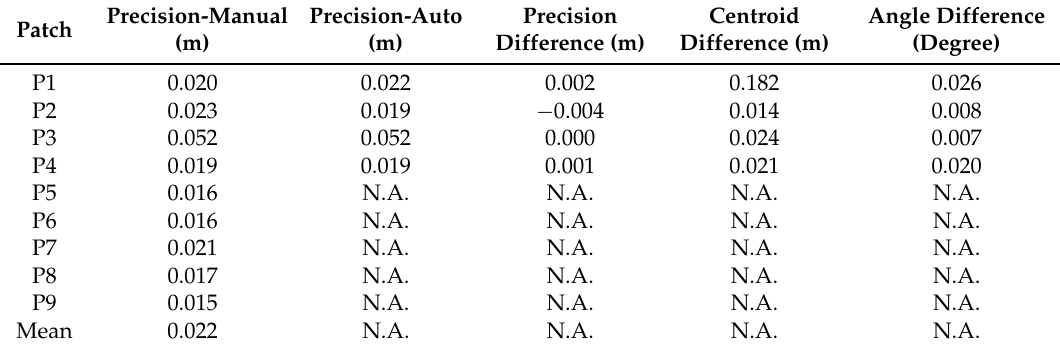
Table 11. Plane fitting precision, plane fitting precision difference, centroid difference, and angle difference values for building #2 (Spherical approach).